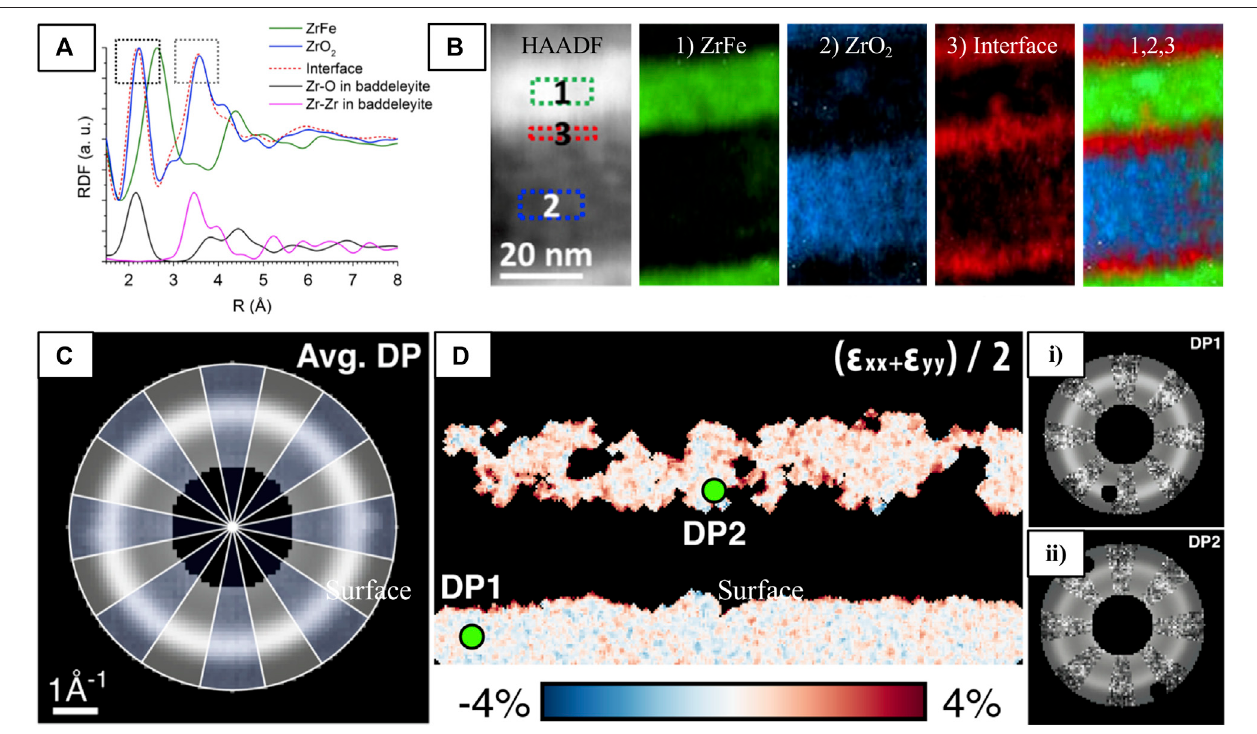
FIGURE 14 | Analysis of amorphous materials with 4D-STEM to map (A,B) the atomic arrangement of ZrO 2 /ZrFe multilayers and (C,D) strain in the irradiated GTO sample. (A) RDFs taken from the amorphous ZrFe (green), ZrO 2 (blue), and interfacial layers (red). The interface RDF is similar to the ZrO 2 RDF with shifts in the fi rst (0.04 Å, left) and second (0.06 Å, right) peaks indicated by black boxes. Comparison with the calculated Z-O (black) and Zr-Zr (pink) partial RDFs based on monoclinic crystalline baddeleyiteZrO 2 demonstrate that the SRO of ZrO 2 and theinterfacial layer is similar to baddeleyite, and the shifts to reduced atomic distances can be explained by Fe replacing Zr in the ZrO 2 clusters at the interface. (B) From left to right, STEM-HAADF image of the ZrO 2 /ZrFe layered structure, and maps corresponding to regions 1) ZrFe, 2) ZrO 2 , 3) their interface and their composite image. (C) Elliptical fi ts (shown under grey wedges) of the averaged ED pattern (blue wedges) of the amorphous GTO from Figure 12 . (D) A strain map of the amorphized regions and (i,ii) ED patterns from two distinct regions indicated in (D) where the fi tted and raw data alternate azimuthally as in (C) . Reproduced from (A,B) (Mu et al., 2016b) and (C,D) (Savitzky et al.,